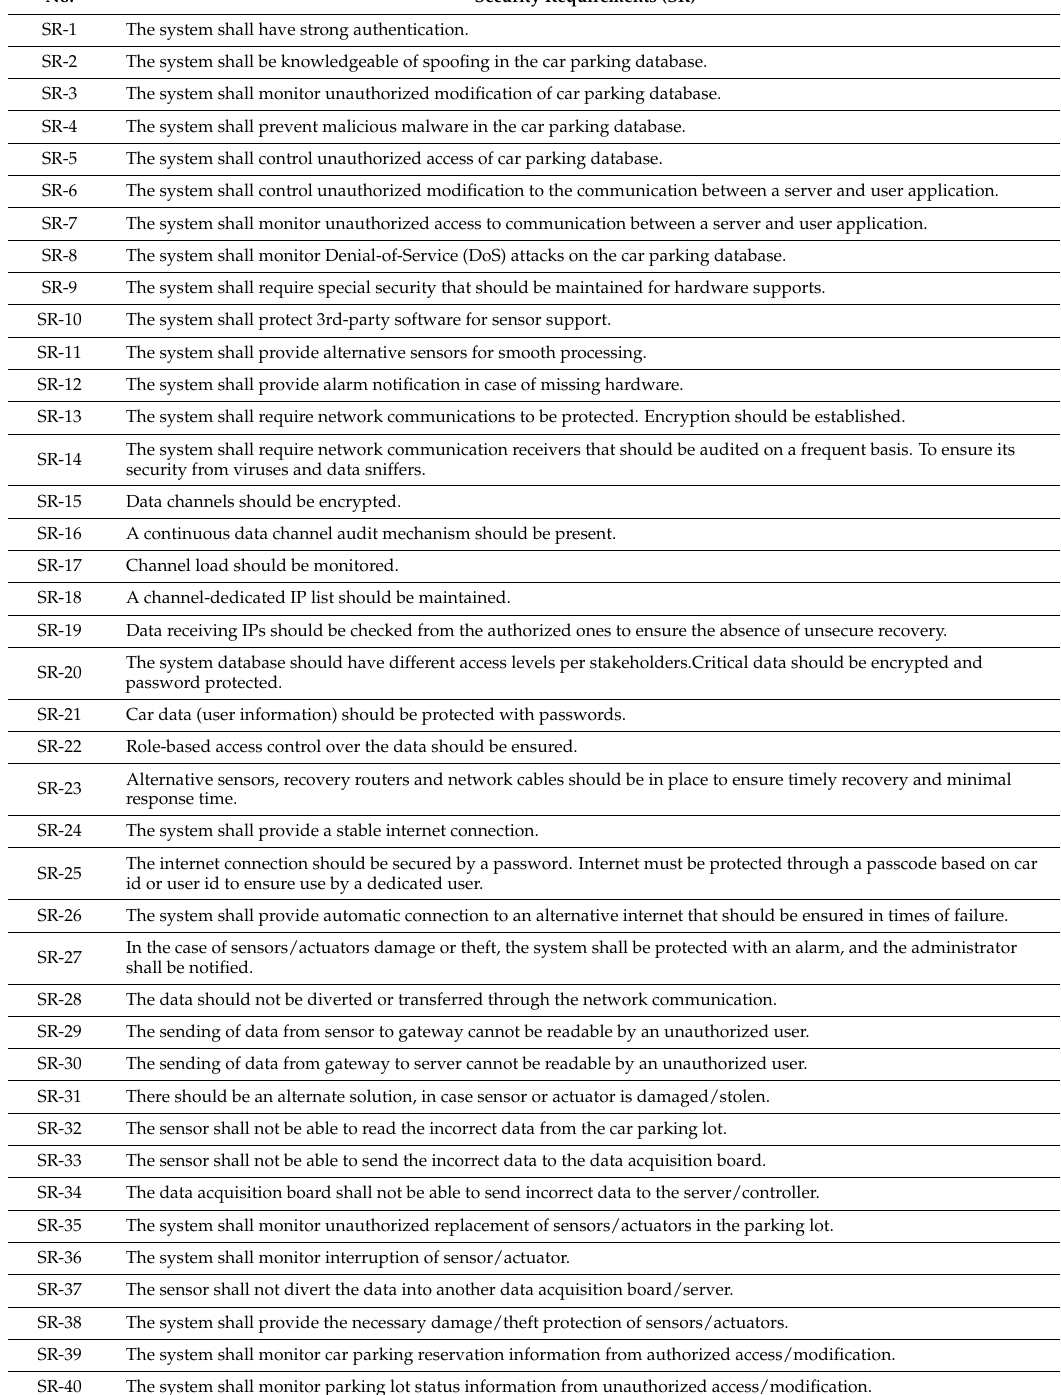
Table 3. Security